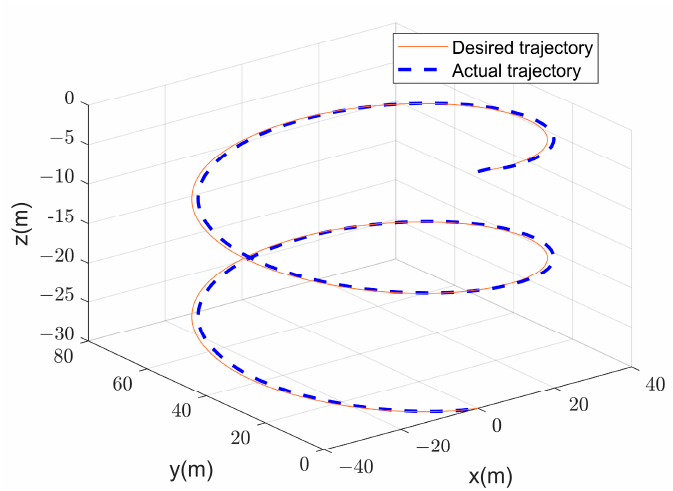
Figure 13. Comparison of desired trajectory and actual trajectory with SIFOFLC.